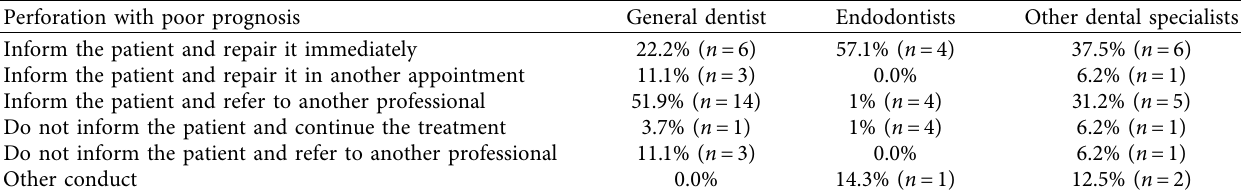
Table 7: Frequency of respondents when related to their conduct in case of perforation with poor prognosis ( p ≥ 0.229). Perforation with poor prognosis